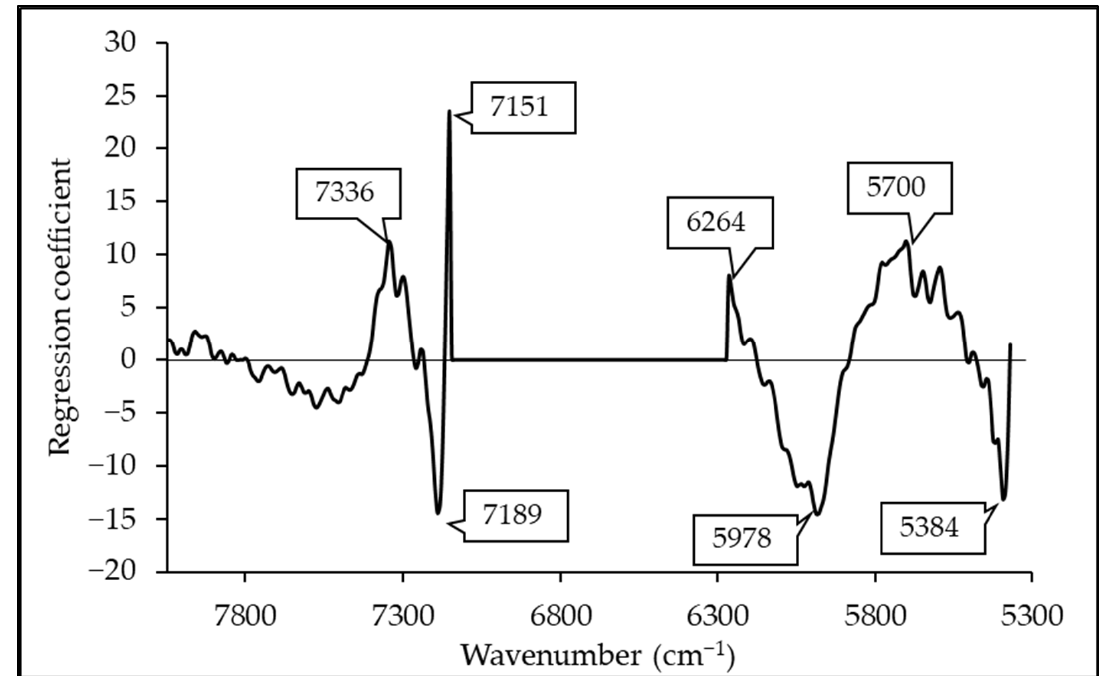
Figure 4. Regression coefficient plot of the PLSR model for TSS prediction in mango purée.